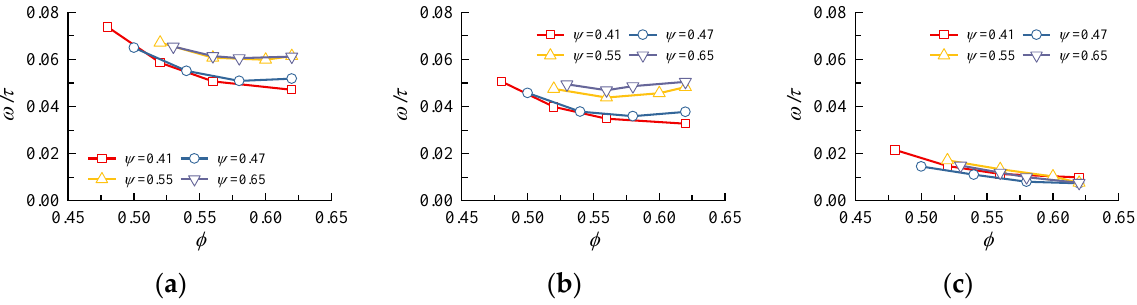
Figure 26. The comparison of rotor loss between different design schemes: ( a ) total loss; ( b ) blade profile loss; ( c ) tip leakage loss.